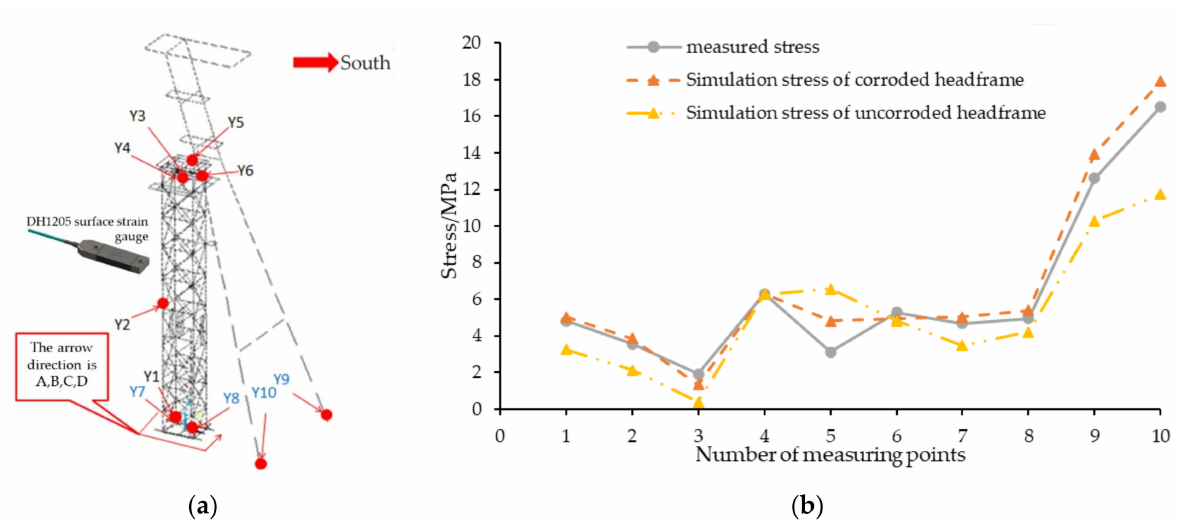
Figure 4. The stress results of each measuring point. ( a ) measuring point arrangement; ( b ) stress of each measuring